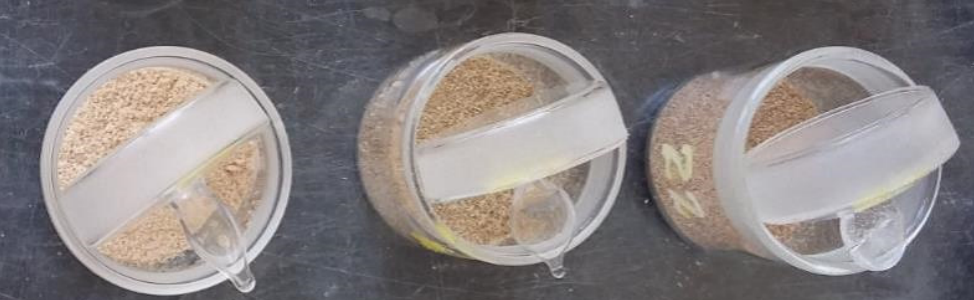
Figure 2. Samples prepared for measurements of the moisture content [Source: Authors’ original photo].